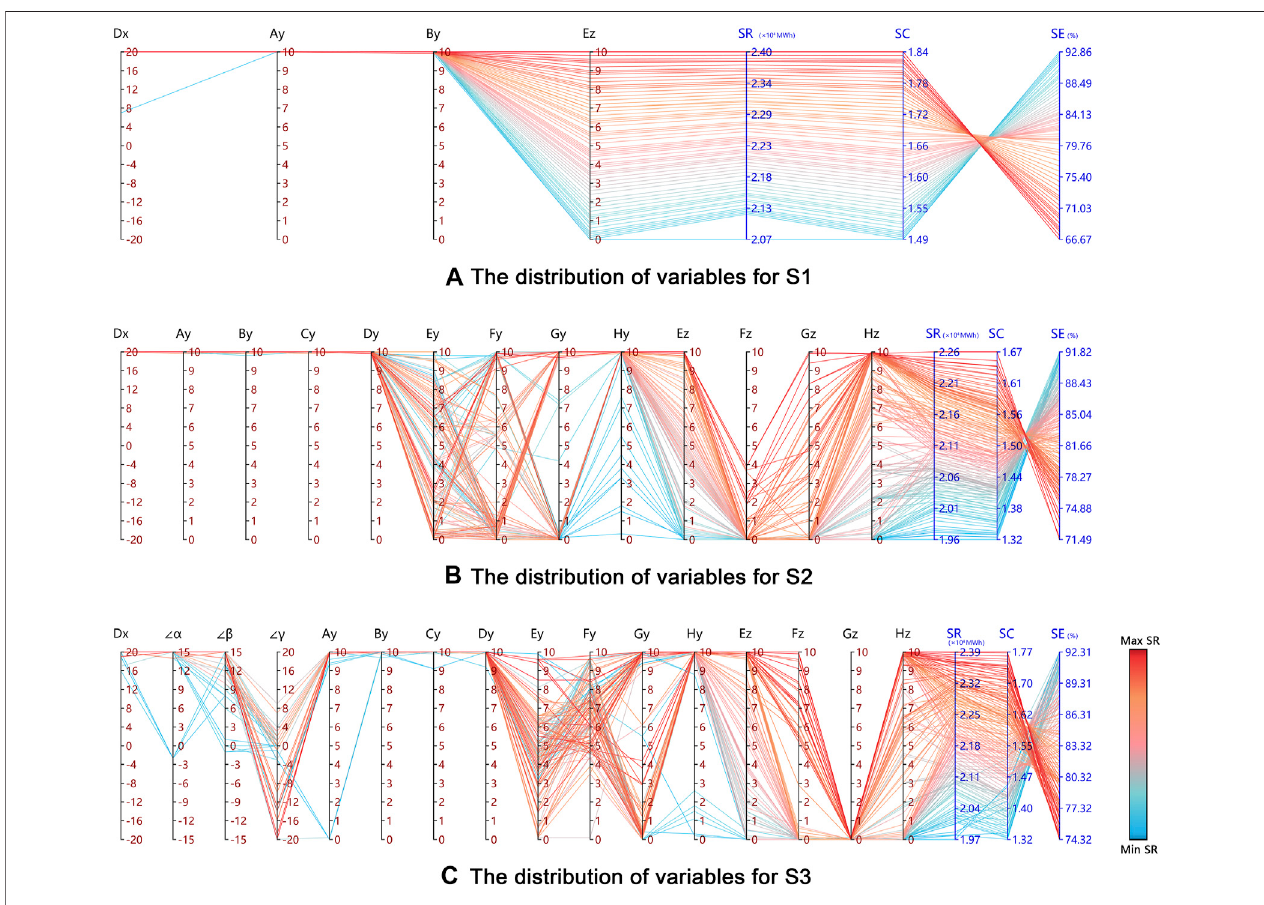
FIGURE 14 | Variable distributions of shapes S1-S3: (A) S1; (B) S2; (C) S3.